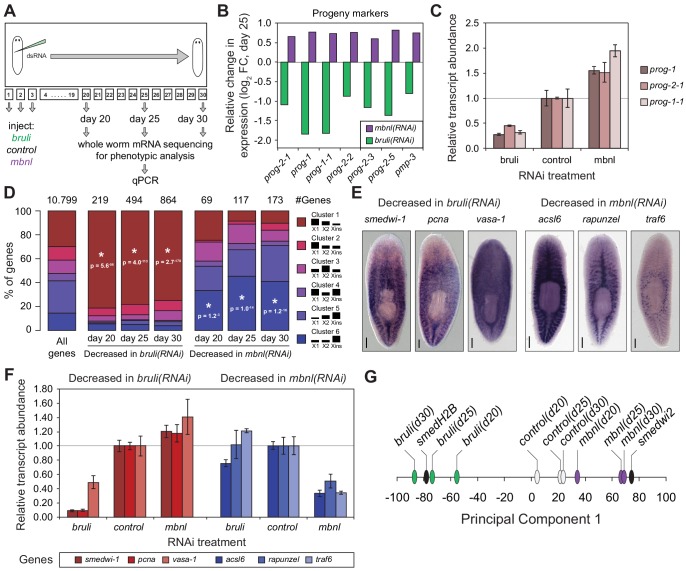
bruli and mbnl antagonistically regulate neoblast biology.(A) Schematic representation of phenotypic analysis experiments. (B) Gene expression changes estimated by RNA-Seq of several progeny markers 25 days after bruli (green) or mbnl (purple) RNAi treatment compared to controls. (C) Quantification of gene expression levels by qPCR of prog-1, prog-2-1, and prog-1-1 in whole worms 25 days after treatment with bruli, control or mbnl RNAi. (D) Proportion of genes belonging to each of the 6 clusters defined in (Onal et al., 2012) based on their X1vs Xins enrichment that are decreased 20, 25 and 30 days after bruli and mbnl RNAi treatment. P-values correspond to hypergeometric tests for Clusters 1 (P = 5.6 × 10−56, P = 4.0 × 10−113, P = 2.7 × 10−178, for bruli(RNAi) days 20, 25 and 30, respectively) and 6 (P = 1.2 × 10−3, P = 1.0 × 10−14, P = 1.2 × 10−16, for mbnl(RNAi) days 20, 25 and 30, respectively). All other tests were not significant. Black histograms on the right side indicate schematically, for each cluster, the relative gene expression levels in each cell fraction. (E) In situ hybridization of three representative Cluster 1 (red bars) and Cluster 6 (blue bars) genes in whole worms. (F) qPCR-based gene expression estimates of three representative Cluster 1 (red bars) and Cluster 6 (blue bars) genes in whole worms 25 days after bruli, control or mbnl RNAi. (G) Principal Component 1 separates transcriptomes from bruli RNAi treated samples together with Smed-H2B(RNAi)(which affects neoblast self-maintenance) from mbnl RNAi treated samples together with Smedwi-2(RNAi)(which impairs neoblast differentiation).